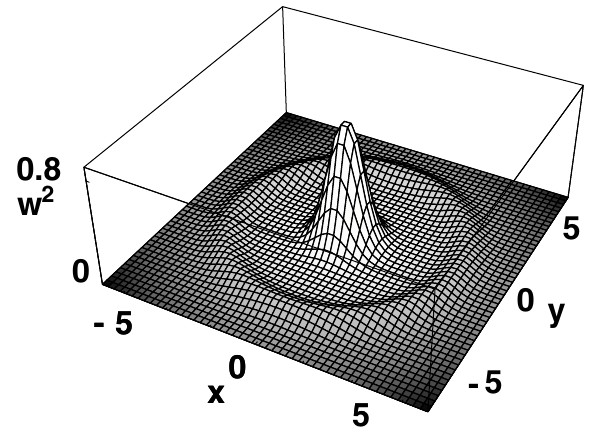
FIG. 15. Plot of the cylindrically symmetric density distri- p (cid:1)(cid:1)(cid:1)(cid:1)(cid:1)(cid:1)(cid:1)(cid:1)(cid:1)(cid:1)(cid:1)(cid:1)(cid:1)(cid:1)(cid:1)(cid:1) (cid:3) given by Eq. (96), which x 2 (cid:5) y 2 bution of the beam w 2 (cid:2) shows a halo ring surrounding the beam core.